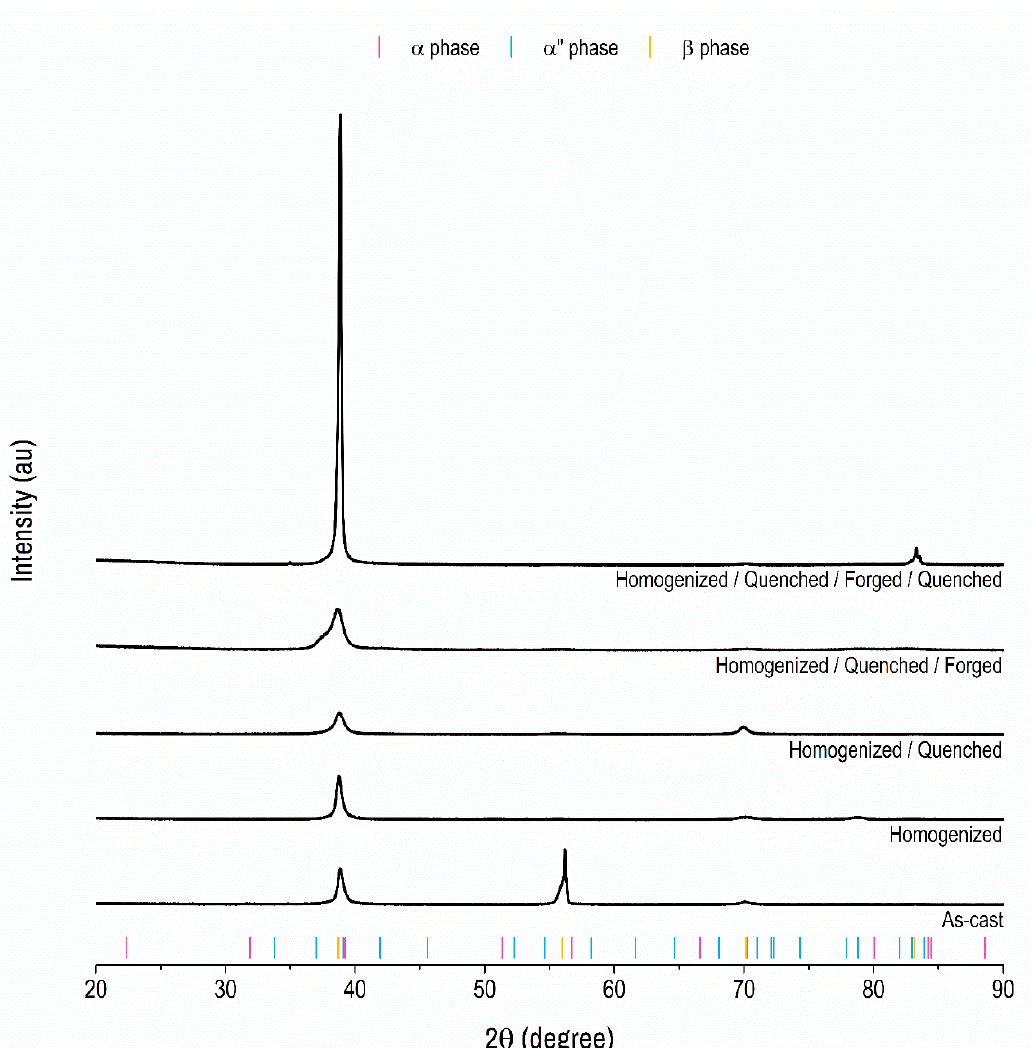
Figure 1. X-ray diffraction pattern of the Ti 10 Mo 8 Nb 6 Zr alloy. The black lines represent the X-ray diffraction pattern of the Ti 10 Mo 8 N 6 Zr alloy at each processing stage, from the melting to the final stage. The pink bars represent the X-ray diffraction pattern of the alpha-phase, according to reference ICSD 197501. The blue bars represent the X-ray diffraction pattern of the alpha” phase, according to reference ICSD 105248. The yellow bars represent the X-ray diffraction pattern of the beta phase, according to reference ICSD 76165.